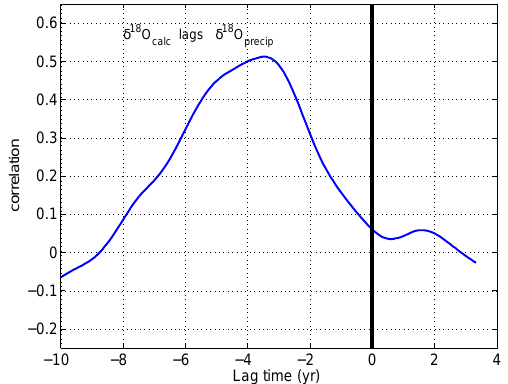
Fig. 5. Lag correlation between the 5-yr low-pass filtered δ 18 O precip and δ 18 O calc values. δ 18 O calc lags δ 18 O precip by 3–4yr. Values above 0.41 are statistically significant taking into account the de- grees of freedom